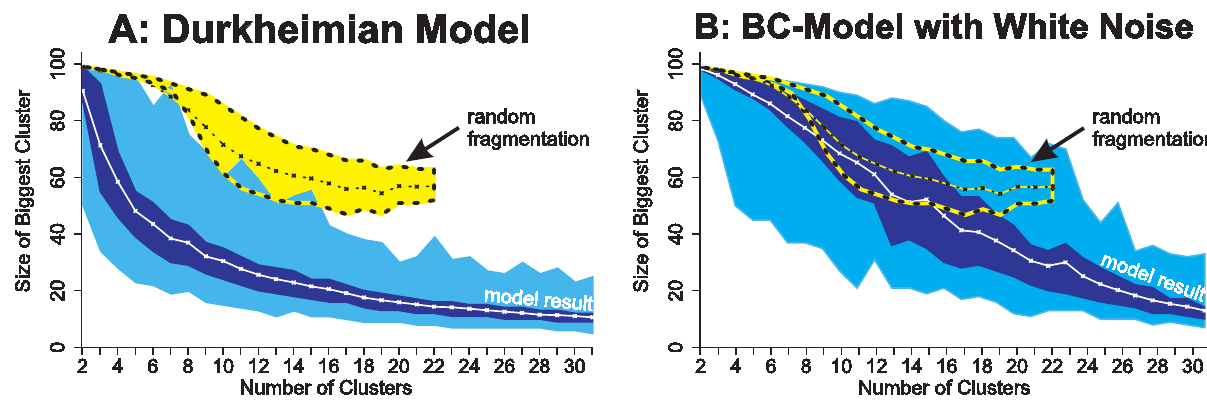
Figure 4. Comparison of the (A) Durkheimian model and (B) the noisy BC-model. Figures plot the size of the biggest cluster versus the number of clusters and compare it to the case of random fragmentation in all simulation runs that resulted in more than one and less than 32 clusters. Fig. 4A is based on the simulation experiment with the Durkheimian model underlying Fig. 3. Fig. 4B is based on an experiment with the BC- model [33] where we varied the bounded-confidence level E between 0.01 and 0.15 in steps of 0.02 and the noise level h between 5 and 50 in steps of 5. We conducted 100 replications per parameter combination and measured the number of clusters and the size of the biggest cluster after 250,000 iterations. White solid lines represent the average size of the biggest cluster. The dark blue area shows the respective interquartile range and the light blue area the complete value range. For comparison, we generated randomly fragmented opinion distributions of N ~ 100 agents where n agents hold random opinions ( N (0,50) ) and the remaining N { n agents hold opinion o i ~ 0 and form one big cluster. We varied the value of n between 0 and 100 in steps of 1 and generated 1000 distributions per condition. The average size of the biggest cluster of the resulting distributions is shown by the thin yellow-black line. (The curve stops at 22, since this is the highest number of clusters generated.) The bold yellow-black lines represent the related interquartile range. We find that the value range of the Durkheimian model (blue area) hardly overlaps with the interquartile range of the fragmented distributions (yellow area). This demonstrates that the Durkheimian model shows clustering rather than fragmentation. In contrast, Fig. 4B illustrates that the distributions of the noisy BC-model and the results for random fragmentation overlap.